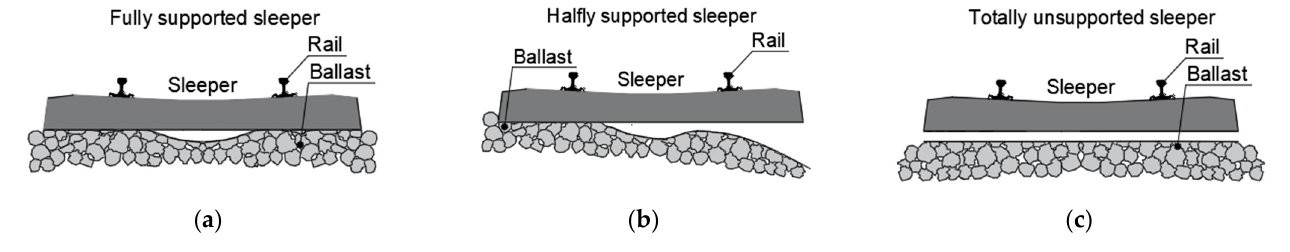
Figure 7. Different sleeper support conditions: ( a ) fully supported sleeper, ( b ) half supported sleeper and ( c ) totally unsupported sleeper.